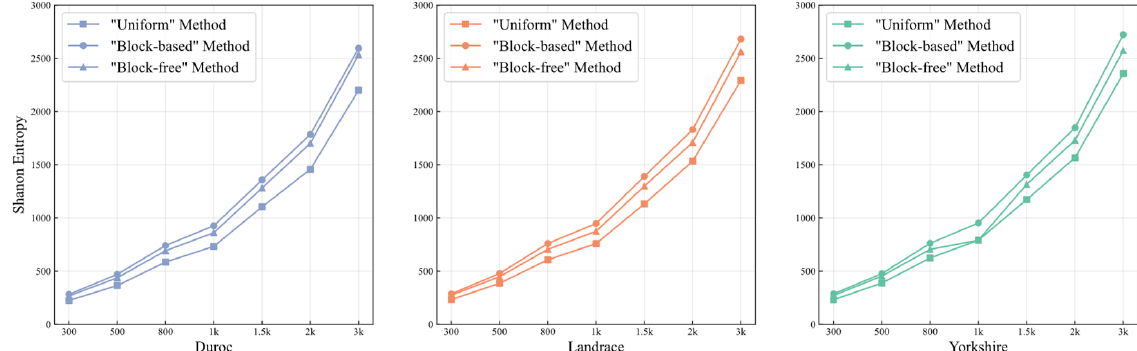
Figure 2. Shannon Entropy of different low-density panels. The horizontal coordinate represented the density of low-density panels, and the vertical coordinate indicated the Shannon Entropy. The shapes of square, circle, and triangle represented the “uniform” method, the “block-based” method, and the “block-free” method, respectively. The colors blue, orange, and green represented Duroc, Landrace, and Yorkshire, respectively.